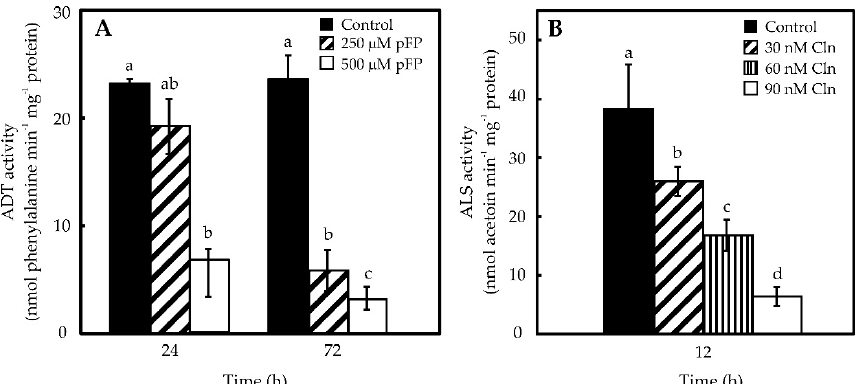
Figure 3. Inhibition of ADT ( A ) and ALS ( B ) specific activities in in vitro maintained placentas. Data represent mean ± standard deviation (S.D.) of three independent experiments with three replicates. Bars labeled with different letters are significantly different (Tukey’s test, α = 0.05).